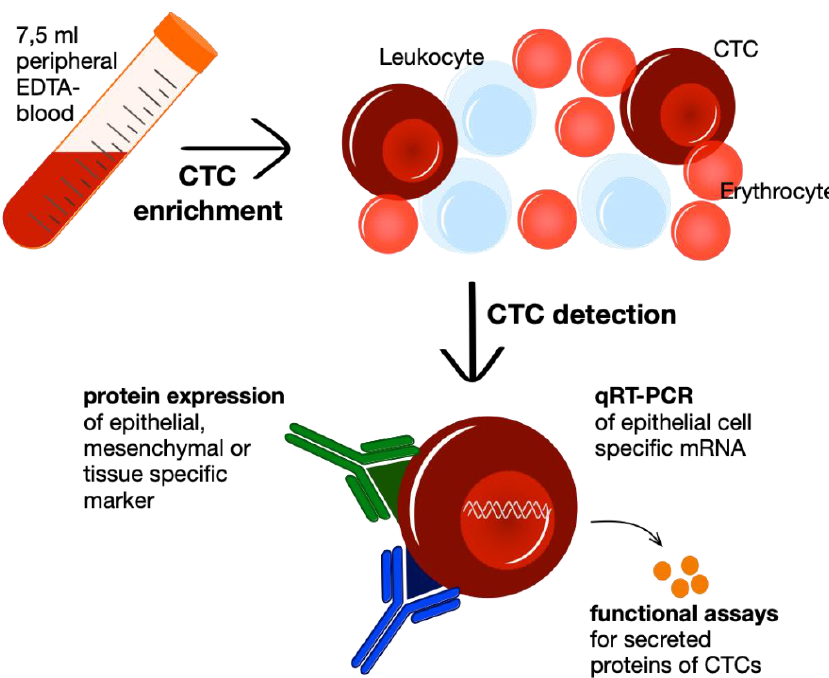
Figure 2. Workflow of liquid biopsy with CTC enrichment and following detection by either immunocytological detection, genome-based identification via pRT-PCR or functional secretion assays of viable CTCs.